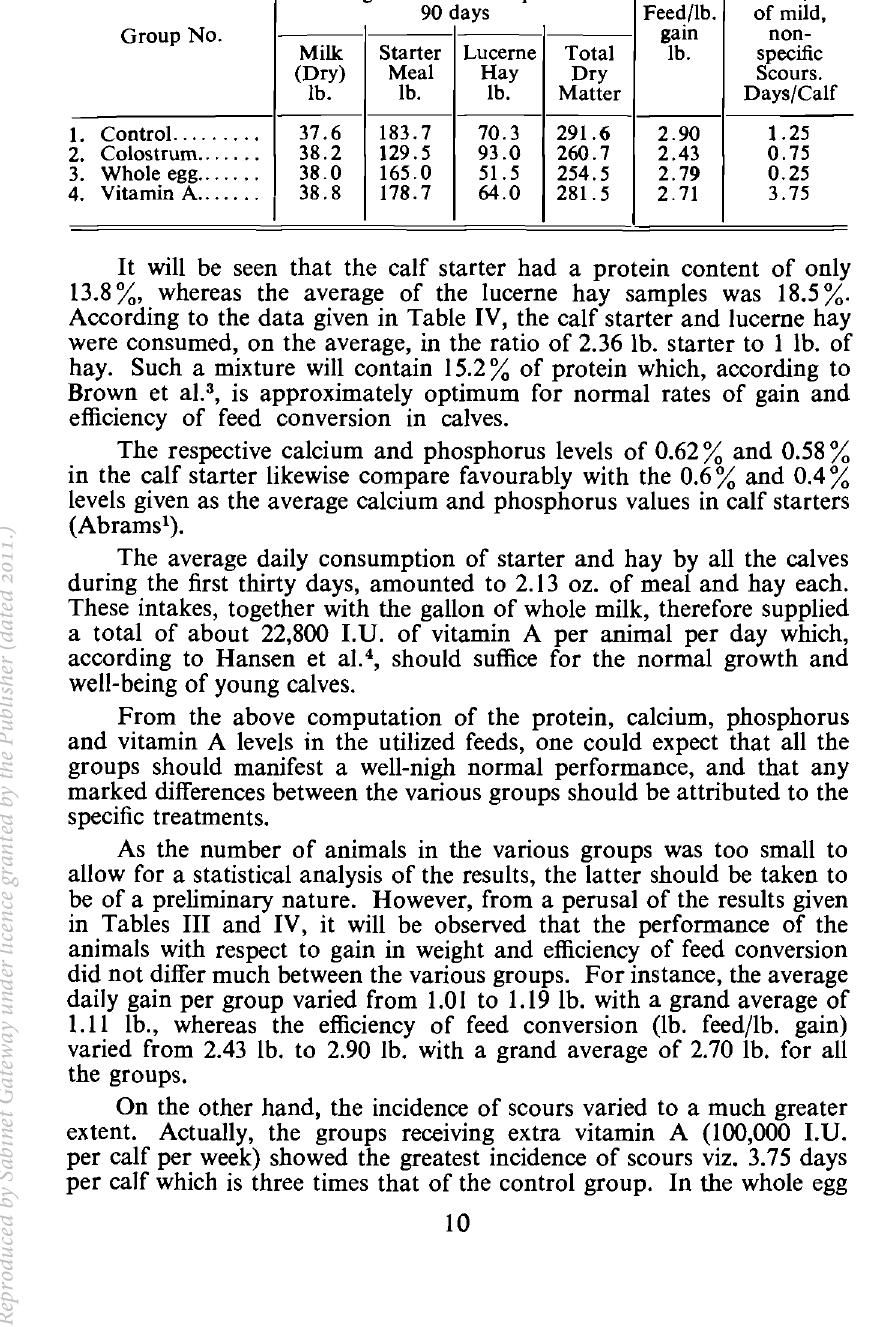
EFFECT OF DEHYDRATED COLOSTRUM, DEHYDRATED WHOLE EGG AND STABILIZED VITAMIN A ON FEED CONSUMPTION, FEED CONVERSION AND INCIDENCE OF SCOURS IN YOUNG DAIRY